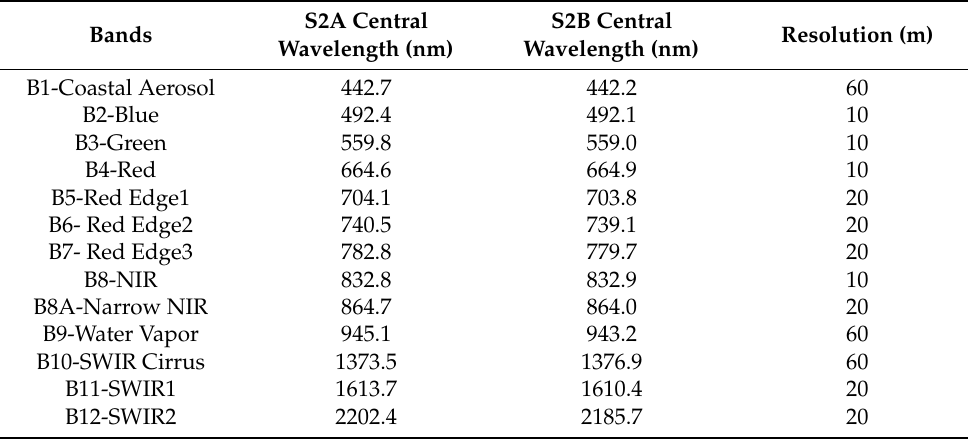
Table 1. Description of the band features of Sentinel-2 images. S2A Bands